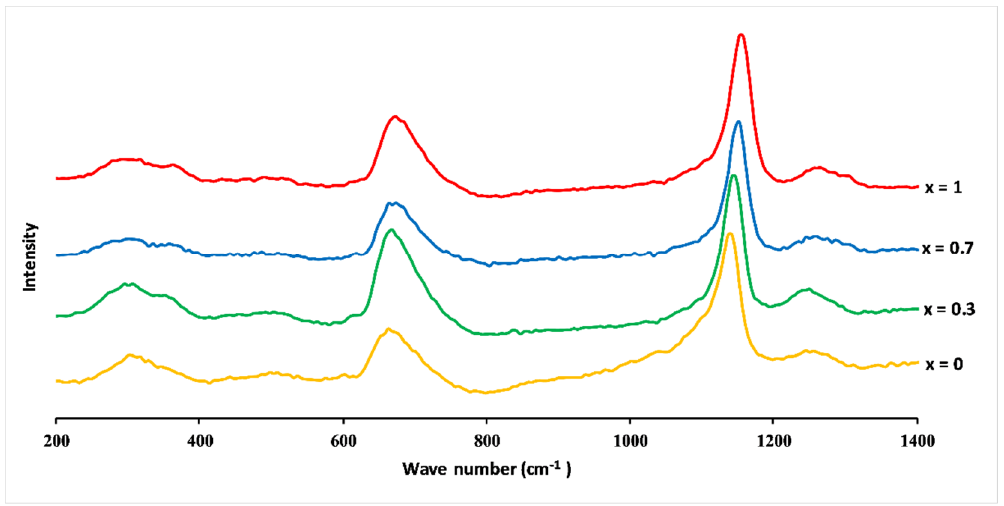
Figure 6. Raman spectra of 3P 2 O 5 -2K 2 O-(1 − x)CaO-xMgO glasses for 0 ≤ x ≤